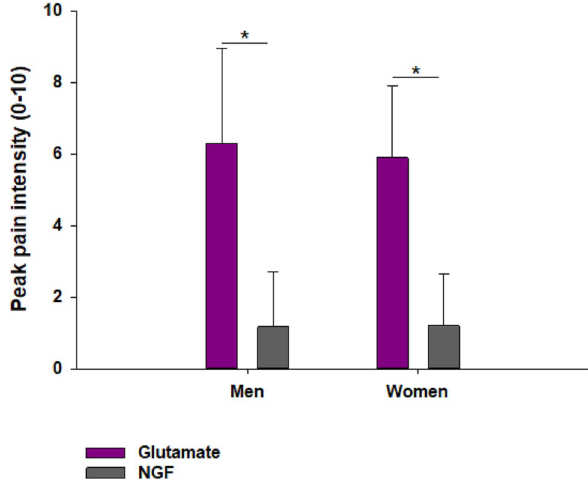
Figure 2. Graph illustrating the pain response to injection of glutamate and nerve growth factor. Peak pain intensities in response to injection of glutamate and nerve growth factor in 15 healthy women and 15 age- matched men. Bars represent mean and whiskers standard deviation (SD) *Significant differences (P <